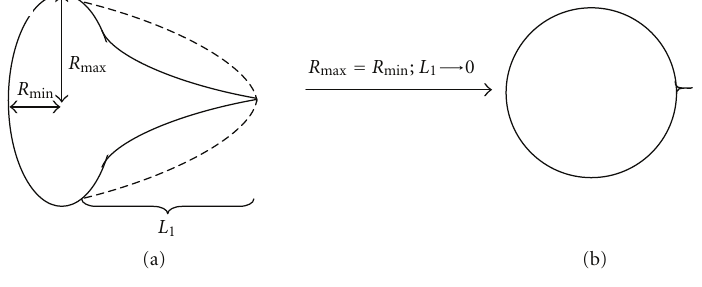
Figure 2: Geometry of motility supporting zone for simulations. (a) Generalized geometry with one part of the zone defined by an ellipse and another part defined by a second degree polynomial (e.g., filled or dashed line). Polynomials selected to be continuous with the ellipse and also with continuity of first derivative. (b) Special case with R max = R min and very small value of L 1 . This special case was exclusively used here.